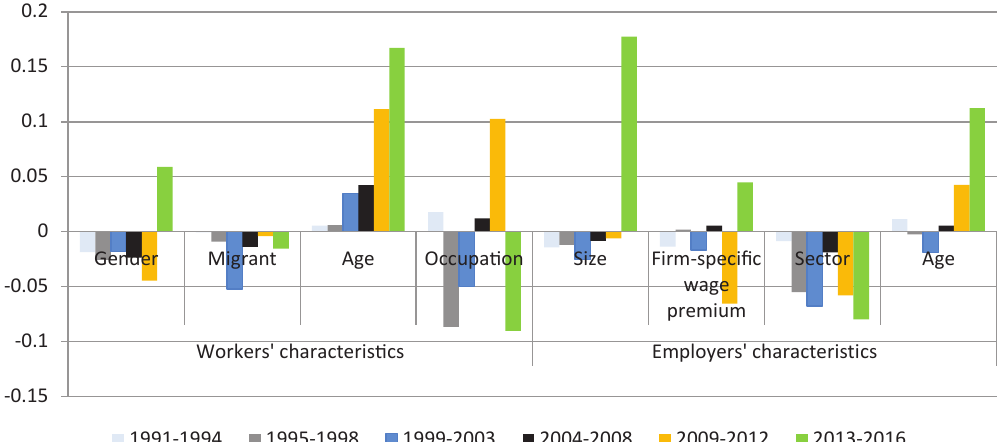
Figure 2 The contribution of some employers’ and workers’ characteristics to the composition effect of aggregate nominal